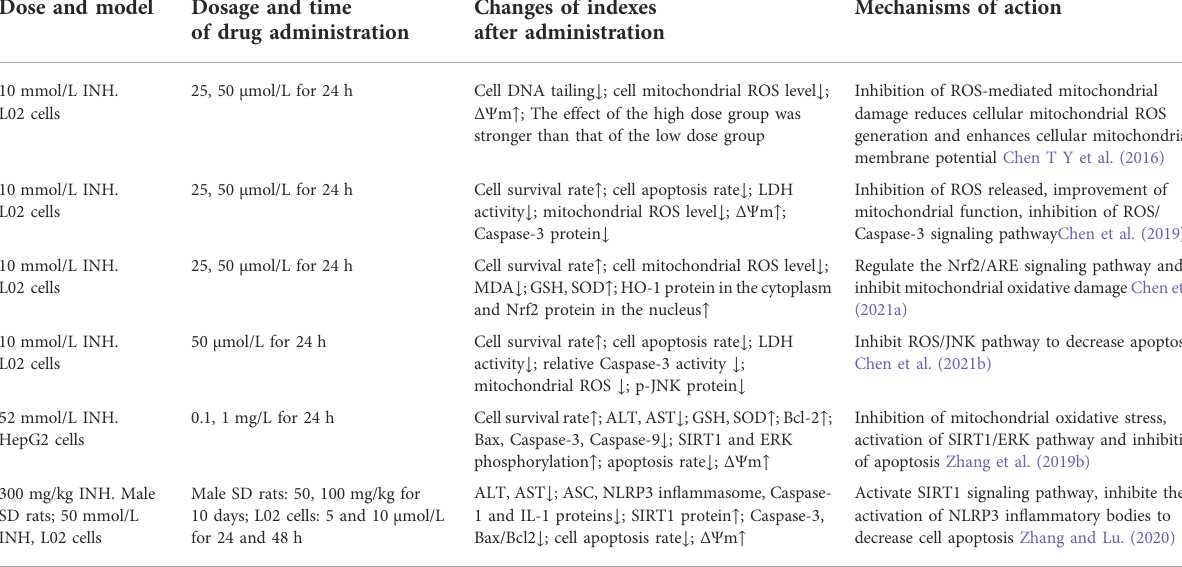
TABLE 3 The protective mechanisms of quercetin on INH-ILI. Dose and